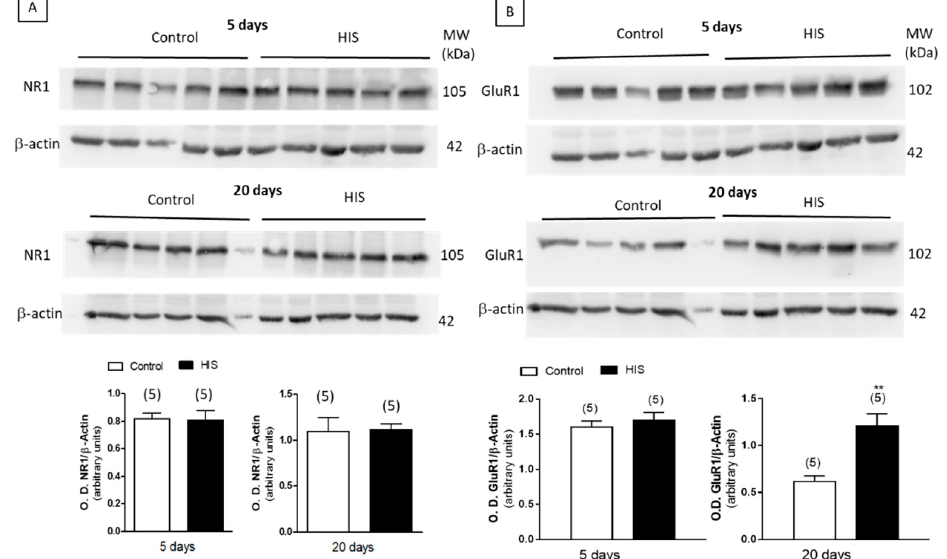
Figure 9. Immunoblotting analysis of alpha subunit of NR 1 ( A ) and GluR 1 ( B ) subunits in cortical plasma membranes from rats 5 and 20 days after HIS. Plasma membranes (40 µ g) were subjected to SDS-PAGE, electrophoretically transferred to nitrocellulose and probed with anti-NMDAR1 and recombinant anti-Glutamate Receptor 1 antibody, as described in Materials and Methods. Data, expressed as arbitrary units, are means ± SEM of experiments performed with five different plasma membrane preparations. ** p < 0.01 using unpaired two tailed Student’s t -test (Supplementary Materials: Figures S9–S14).